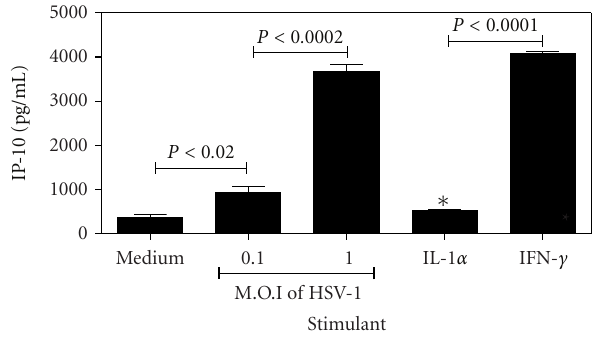
Figure 6: Purified mouse neutrophils produce high levels of IP- 10 in response to stimulation with proinflammatory mediators or HSV-1. 1 × 10 6 neutrophils purified from bone marrow were stimu- lated for 8h in vitro with 10 ng/mL of either recombinant mouse IL- 1 α , IFN- γ , or HSV-1 at the dose indicated. Chemokine production was assayed by ELISA. An asterisk indicates a value not significantly di ff erent from the unstimulated